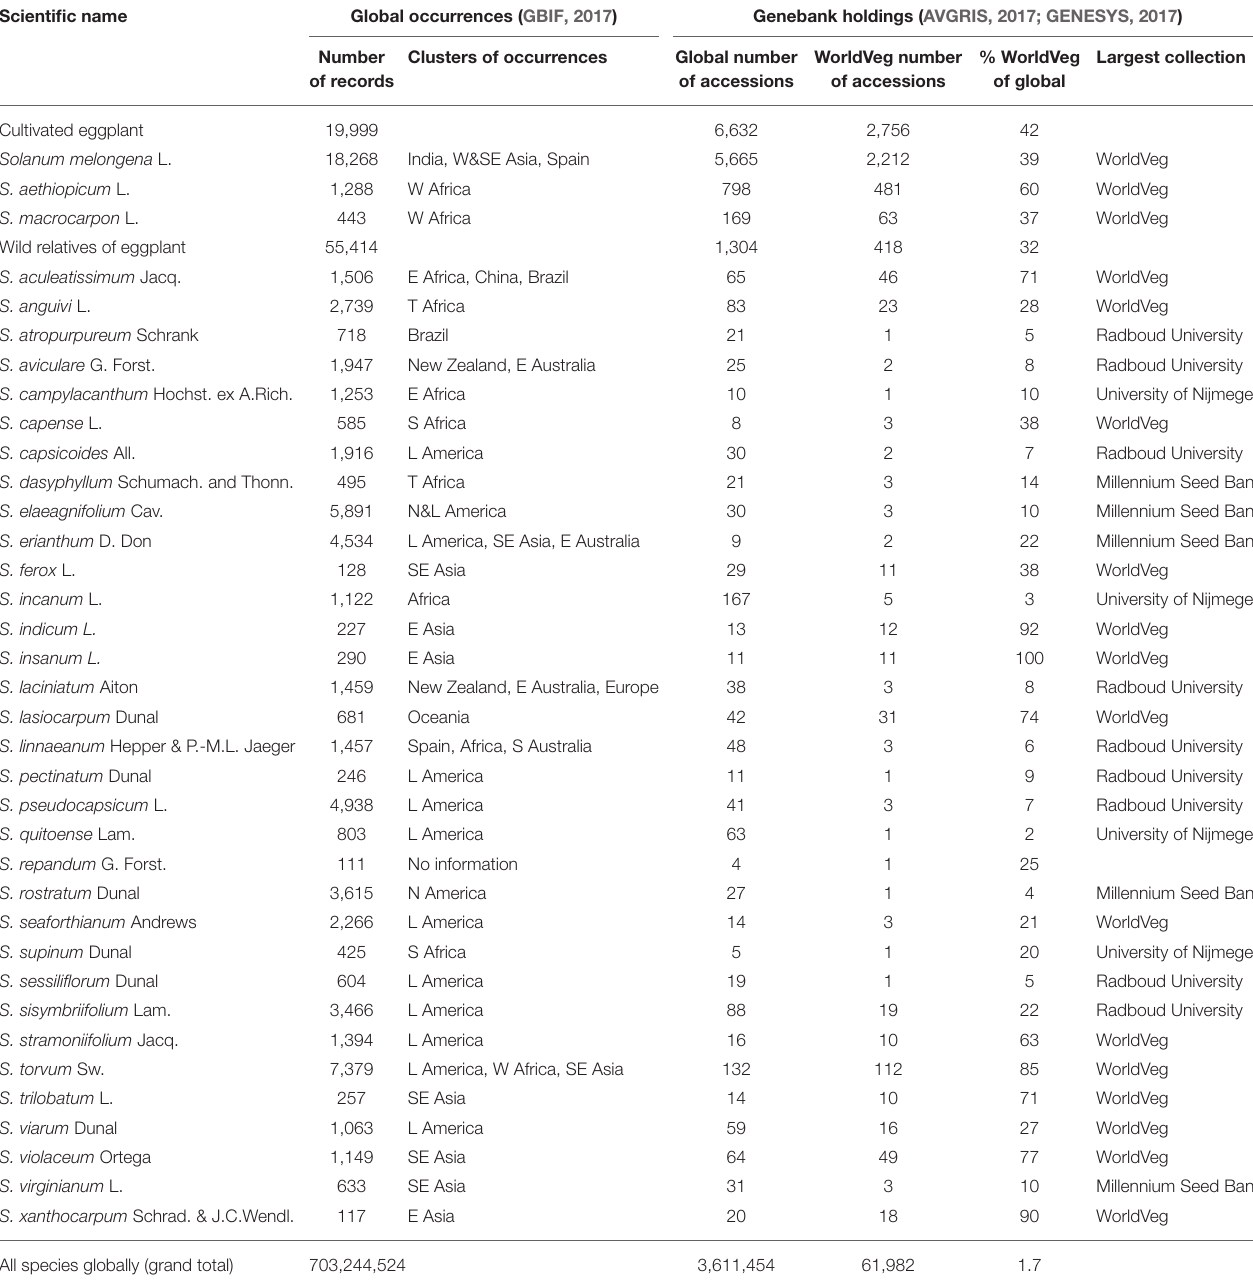
TABLE 2 | Cultivated eggplant and wild relatives, number of occurrences, their regions and number of conserved accessions globally and at the World Vegetable Center (WorldVeg). Scientific